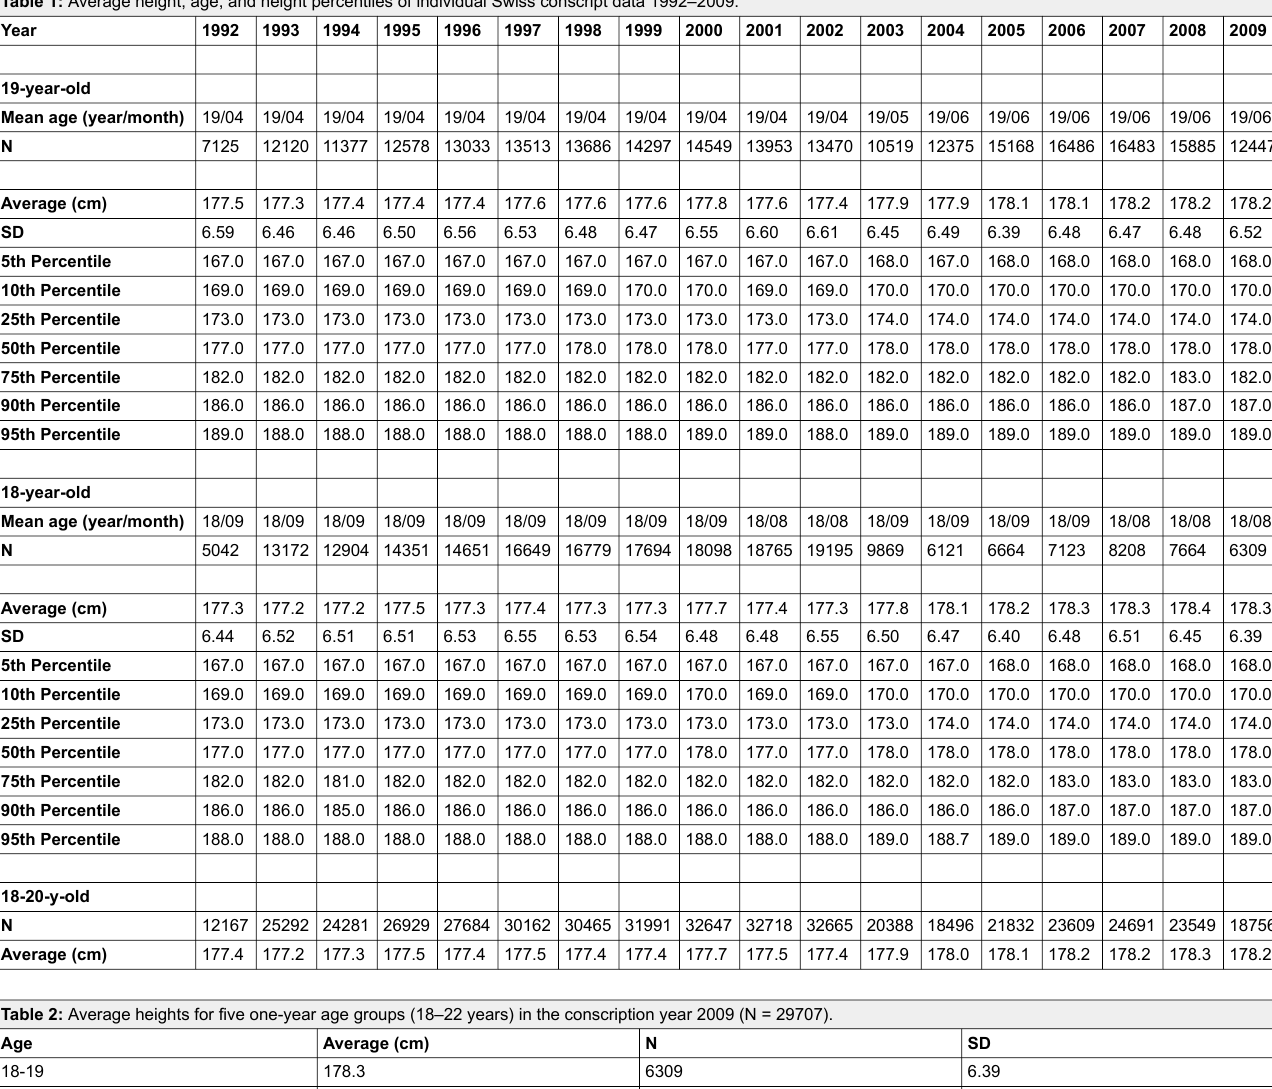
Table 1: Average height, age, and height percentiles of individual Swiss conscript data 1992–2009.